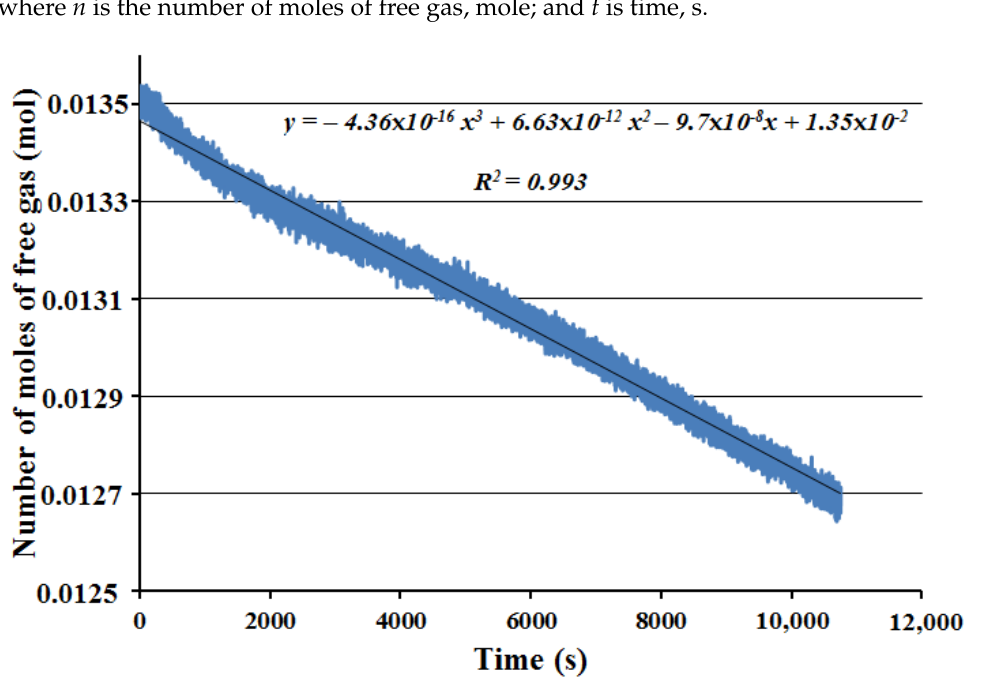
Figure 12. Period of the first nuclei of the hydrate formation process until the end of experimental process after 3 h.